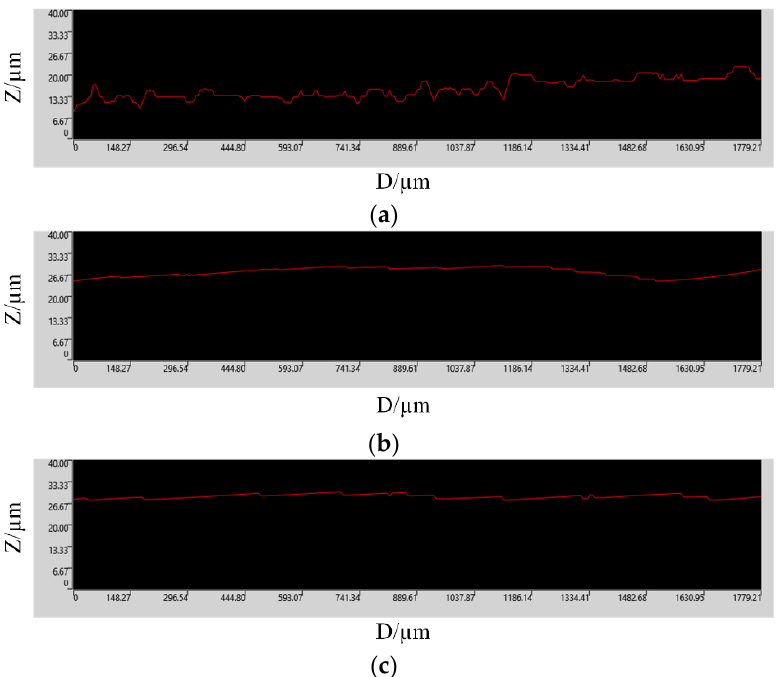
Figure 7. Surface roughness of SiC workpiece. ( a ) Non-auxiliary turning experiment, ( b ) Orthogonal optimization experiment, ( c ) Response surface optimization experiment.